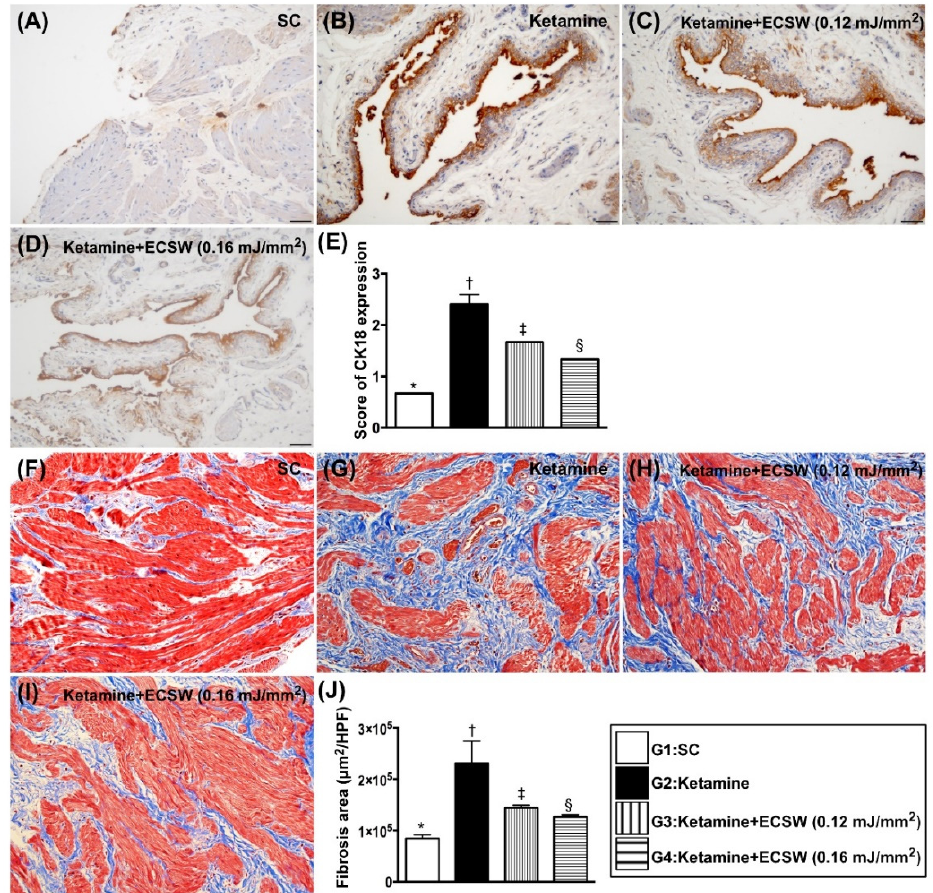
Figure 8. ECSW therapy reduced the ketamine-induced fibrosis and keratinization of urinary blad- der by day 42 after ketamine administration. ( A – D ) Illustrating the immunohistochemical (IHC) microscopic finding (200 × ) for identification of IHC stained intensity of CK18 in urinary bladder epithelial layer (gray color). ( E ) Scoring intensity of CK18 positively-stained expression, * vs. other groups with different symbols (†, ‡, §), p < 0.0001. ( F – I ) Illustrating the Masson’s trichrome stain (200 × ) for identification of fibrosis area in urinary bladder muscle (blue color). ( J ) Analytical result of fibrotic area, * vs. other groups with different symbols (†, ‡, §), p < 0.0001. Scale bar in right lower corner represents 50 µ m. All statistical analyses were performed by one-way ANOVA, followed by Bonferroni multiple comparison post hoc test ( n = 6 for each group). Symbols (*, †, ‡, §) indicate significance (at 0.05 level). ECSW = extracorporeal shock wave.